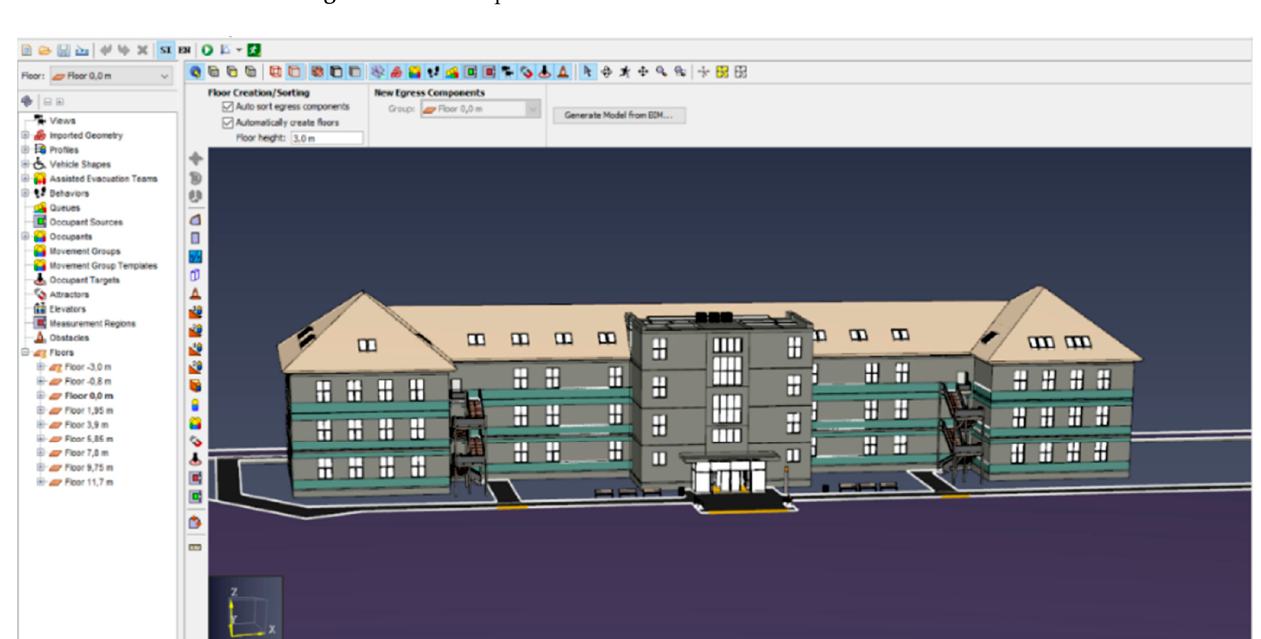
Figure 10. Programme Pathfinder working environment.